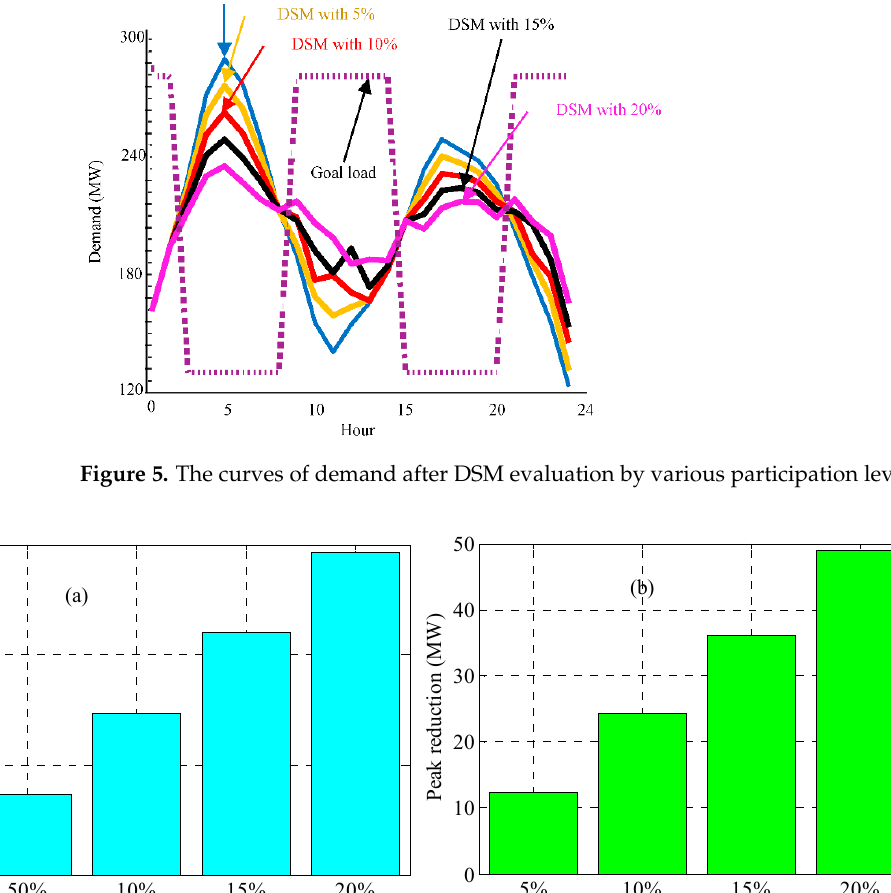
7.284 Figure 7. The convergence features of dynamic economic dispatch by various participation levels of DSM.